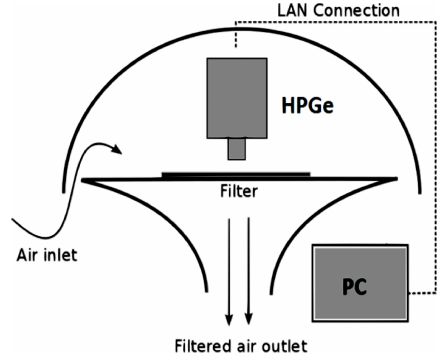
Figure 1. AMARA system schematics; the activity deposition is measured using an HPGe detector above an aerosol filter during sampling. LAN: local area network.